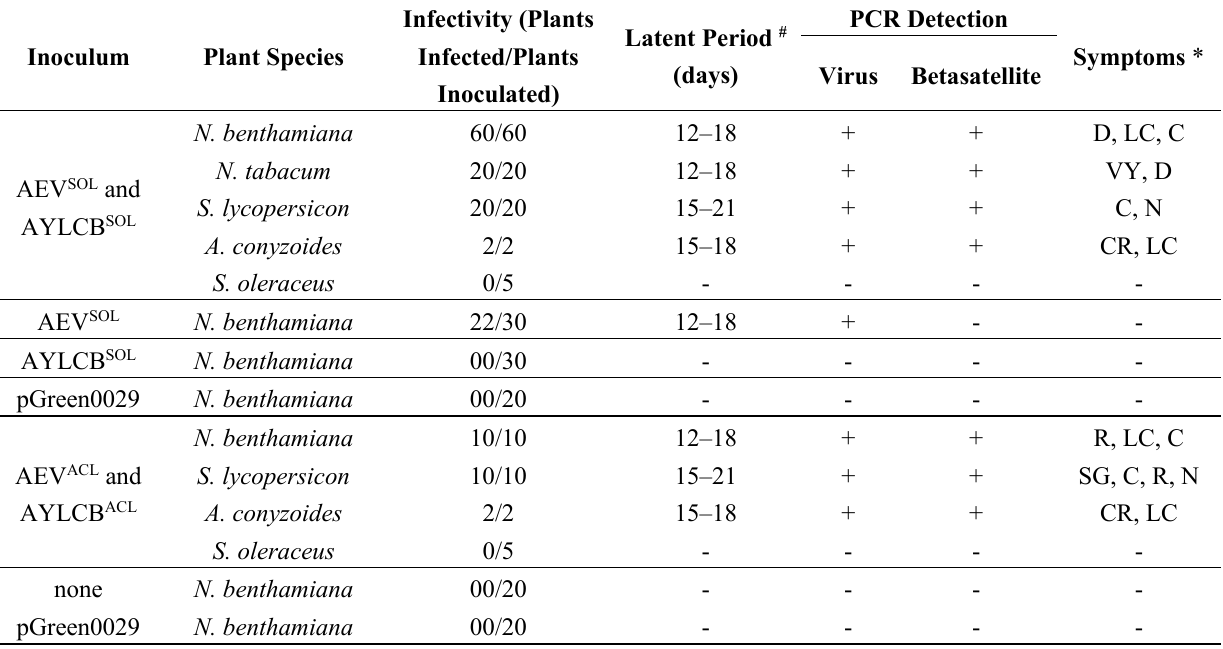
Table 2. Infectivity of AEV, isolates SOL and ACL, with their AYLCB by Agrobacterium -mediated